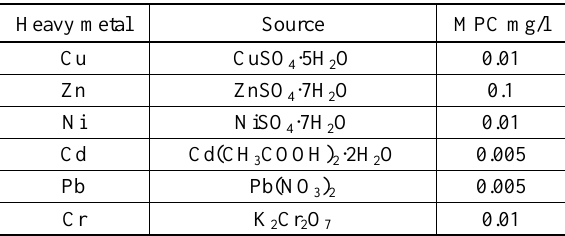
Table 1. Heavy metal concentrations in the mixture to